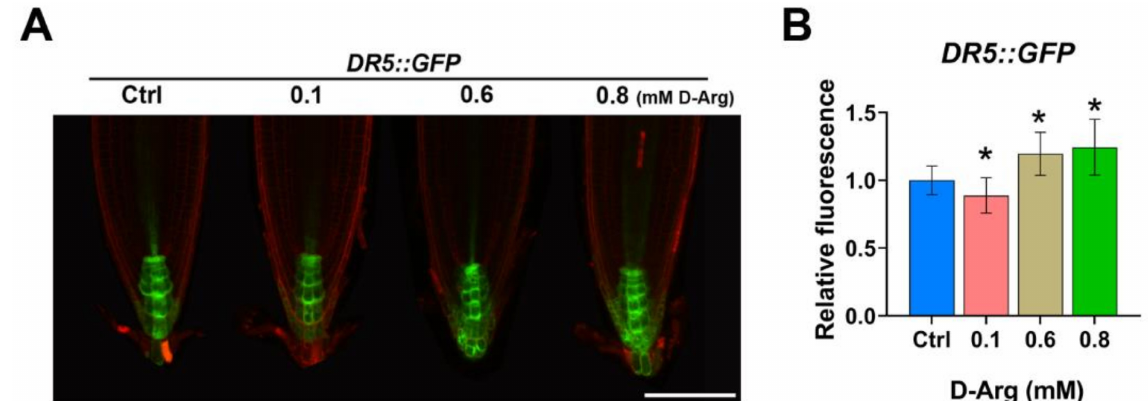
Figure 5. D-Arg treatment has a non-linear effect on auxin response. Five-day-old seedlings at the same developmental stage were transferred to new media containing water (Ctrl) or D-Arg and treated for 3 days. ( A ) Confocal images of DR5::GFP auxin response reporter. ( B ) DR5::GFP normalized fluorescence indicates a non-linear auxin response trend. Data are averages ± SD (n > 15). Scale bar = 100 µ m. Asterisks denote significant differences compared with the control (* p < 0.05; Student’s t